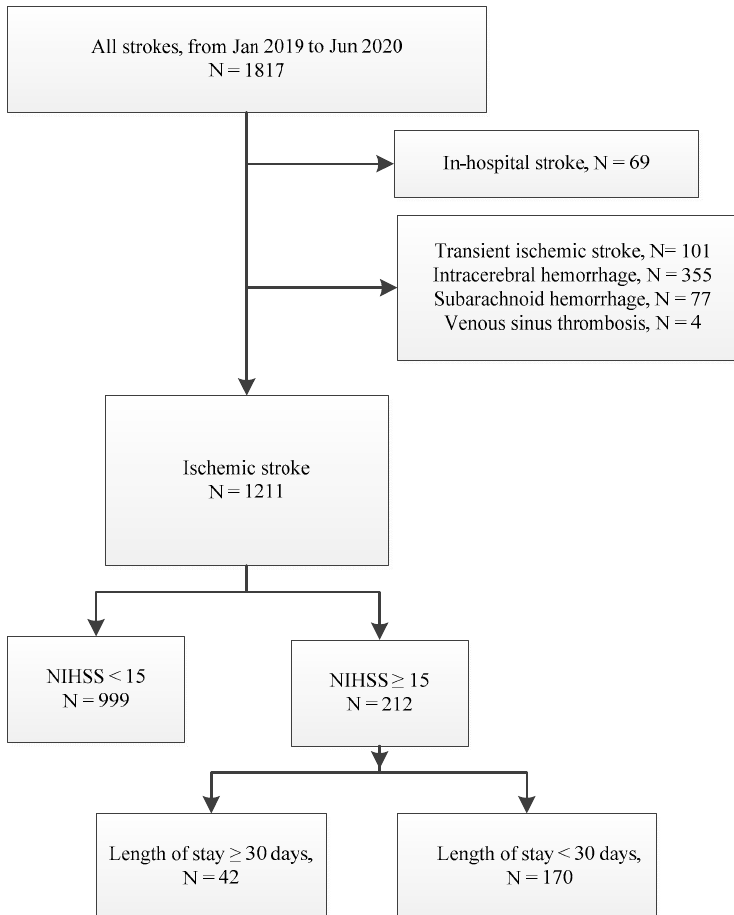
Figure 1. Flow chart of inclusion and exclusion of study patients.